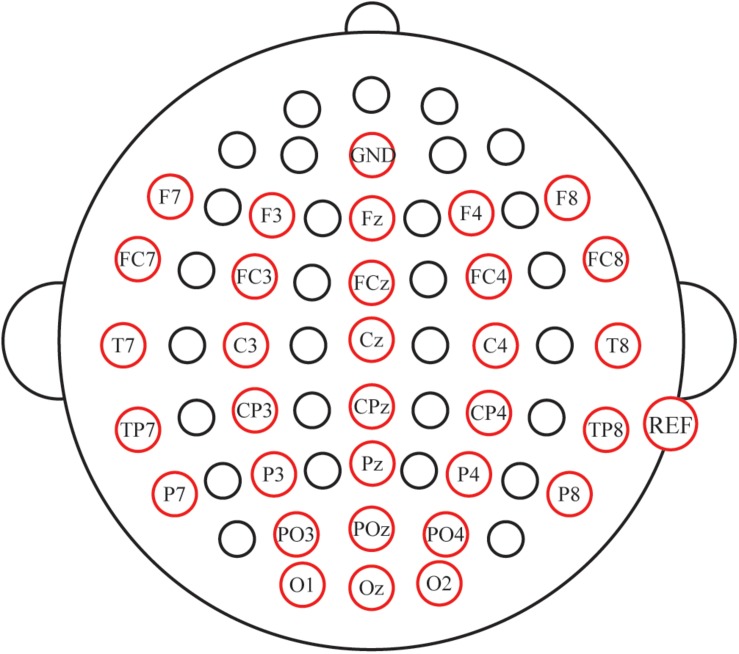
Electrode locations for the study.